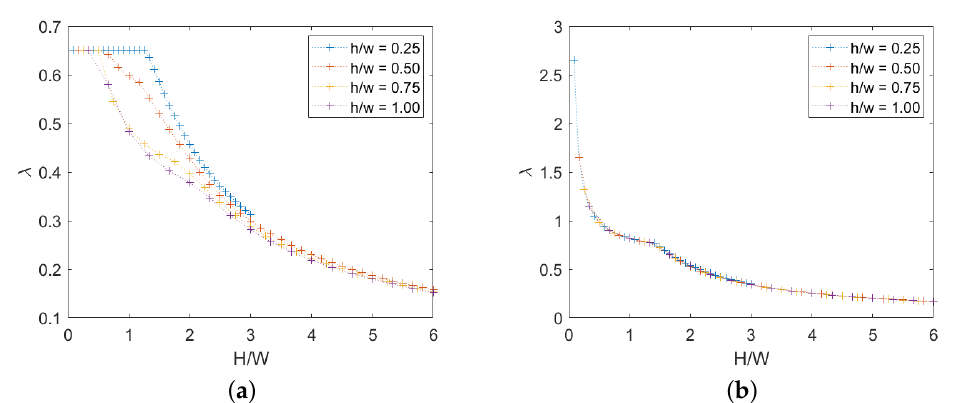
Figure 16. Periodic masonry: failure multiplier for different values of h / w ratio: ( a ) c = 0, ( b ) c =